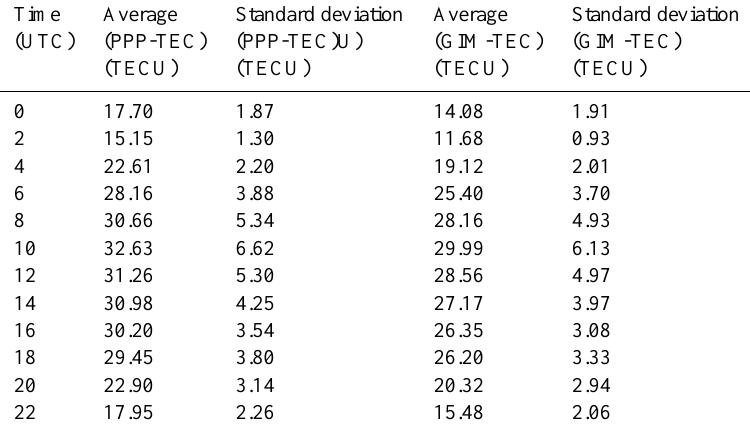
Table 4. IPSA station 2h resolution average TEC data.